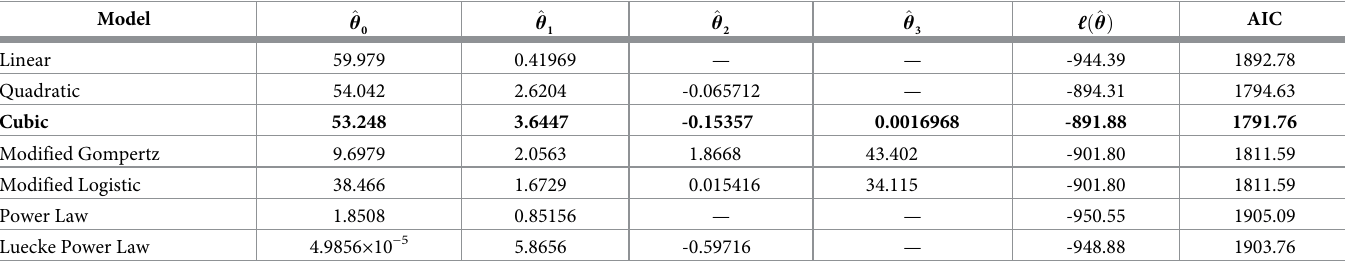
Table 15. Maternal kidney blood flow models (flow rate in L/h vs. maternal mass in kg for power law models, flow rate in L/h vs. gestational age in weeks for all other models).